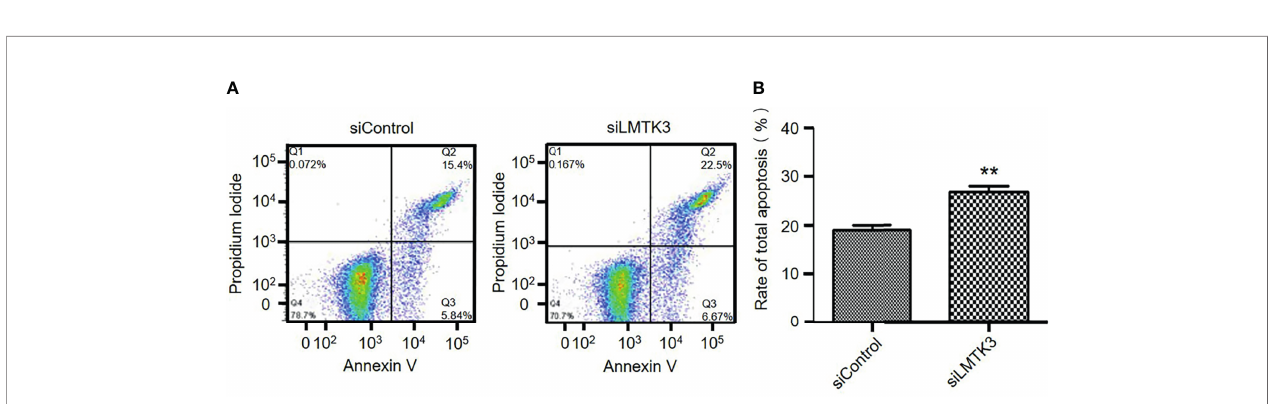
FIGURE 4 | Effects of LMTK3 knockdown on apoptosis in Ishikawa cells by fl ow cytometry. (A) Representative diagrams of LMTK3 knockdown on apoptosis in Ishikawa cells. (B) Statistical histogram of LMTK3 knockdown on apoptosis in Ishikawa (n=3, ** P <